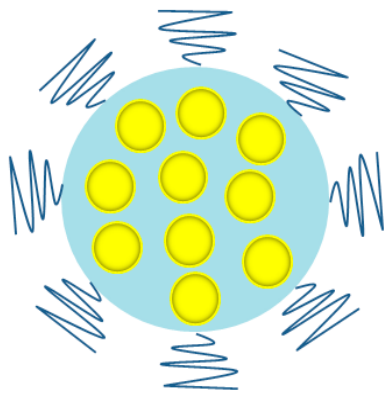
Figure 6. Au NPs encapsulated in polymer nanoparticle. Au NPs—yellow circles, polymer nanoparticle—blue circle, biodegradable polyphosphazene—dark blue wavy lines. (modified from Reference [74]).